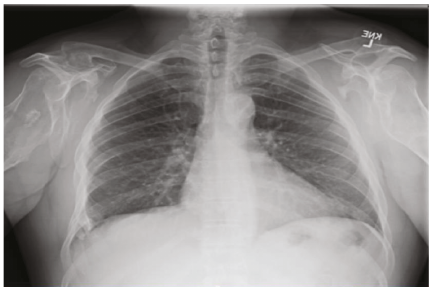
Figure 4: An AP X-ray view displaying multiple osteochondromas at multiple sites in the clavicles, scapulae, and proximal humeri bilaterally as well as multiple right inferior anterior